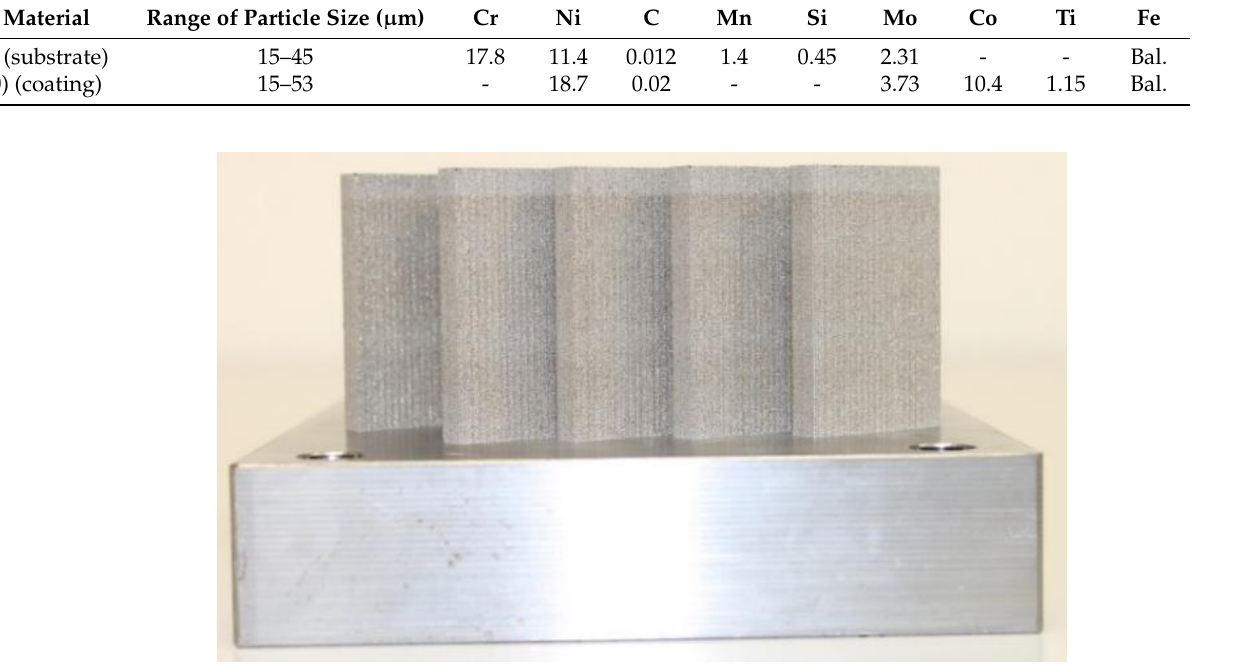
Figure 3. AISI 316L substrates manufactured by using L-PBF technology.